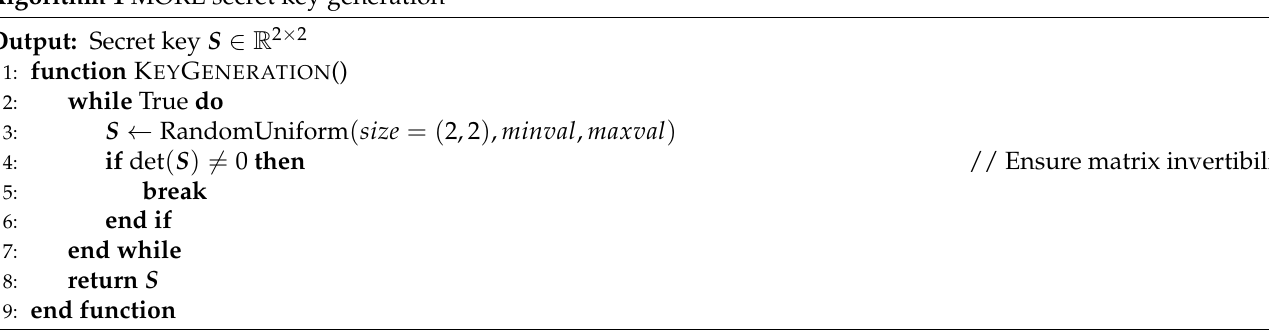
Algorithm 1 MORE secret key generation